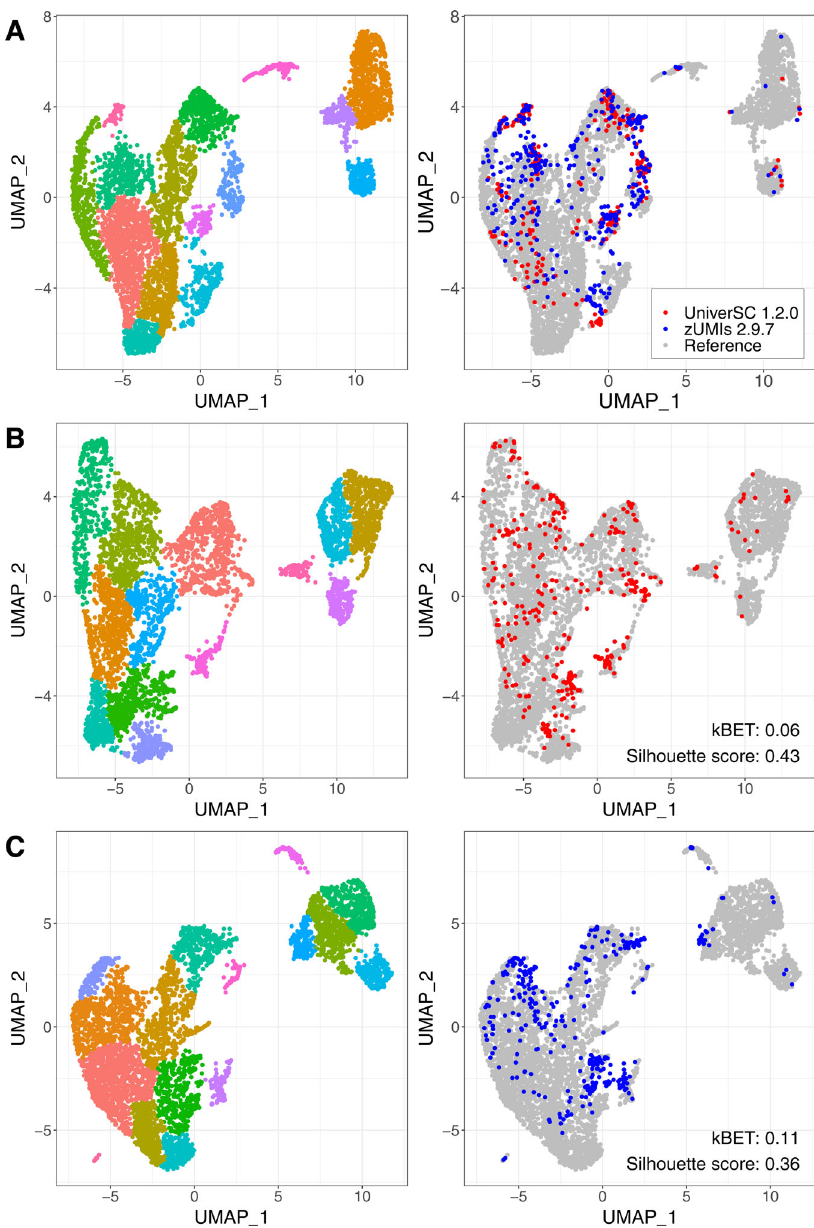
Fig. 3 | Assessment of data integration by UniverSC versus multiple pipelines. IntegrationoutputofChromiumdataprocessedbyUniverSC( “ Reference ” ingrey), SmartSeq2dataprocessedviaUniverSC(inred),andSmartSeq2dataprocessedvia zUMIs (in blue). ( A ) A three-way integration. ( B ) Integration of reference and